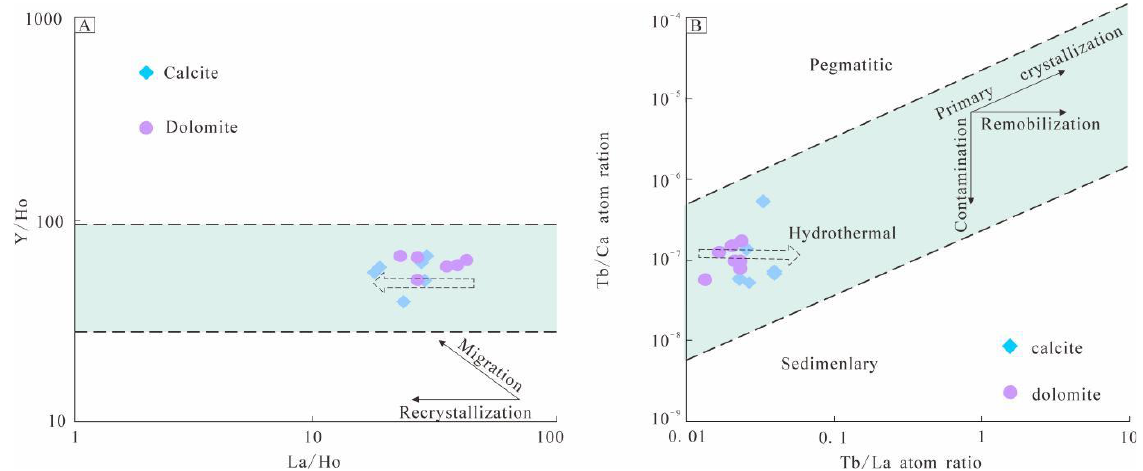
Figure 8. Plots of ( A )Y/Ho versus La/Ho ratios and ( B ) Tb/Ca versus Tb/La ratios for the Lekei calcite and dolomite. (The original base map of A and B after [44 – 45], respectively).